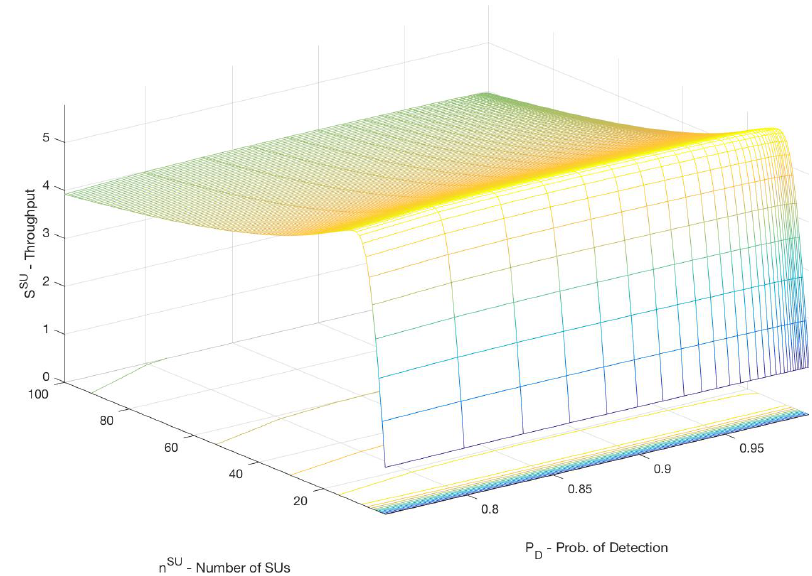
Figure 6. Conditional throughput ( S SU ) achieved by SU versus P D and n SU , for α = 2 and without fading.